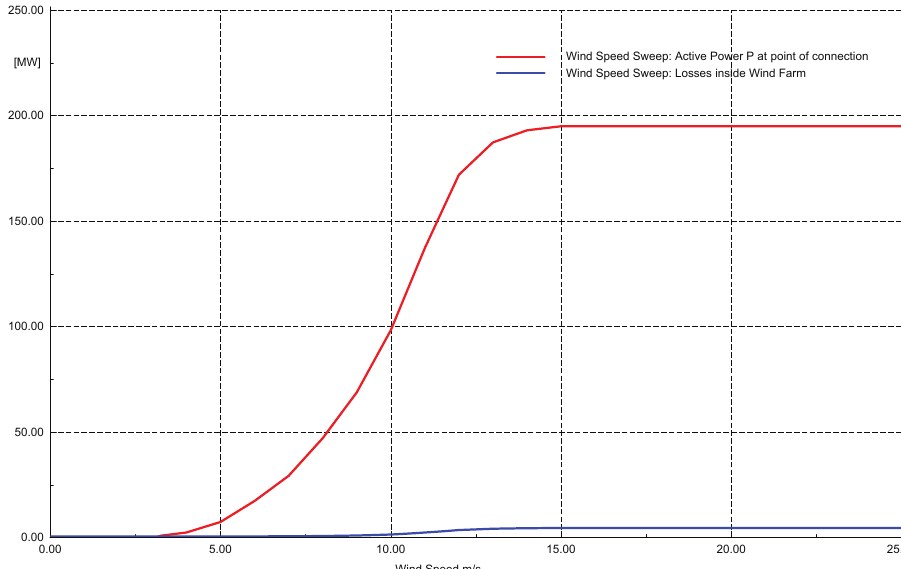
Figure 6. Simulated real power production and losses versus wind sweep speed.